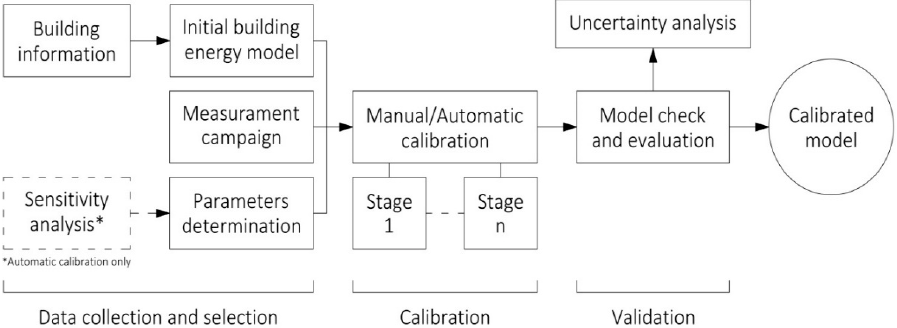
Figure 1. Methodology scheme.